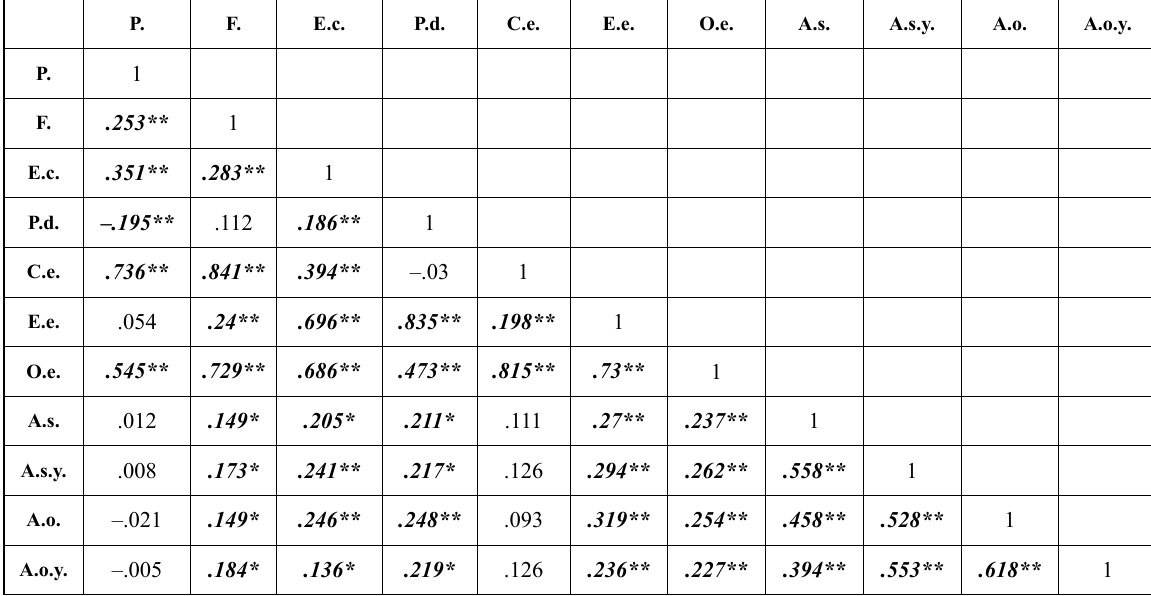
Table 5. Correlation matrix of subscales of Interpersonal Reactivity Index Scale and Revised Collet-Lester Fear of Death and Dying Scale